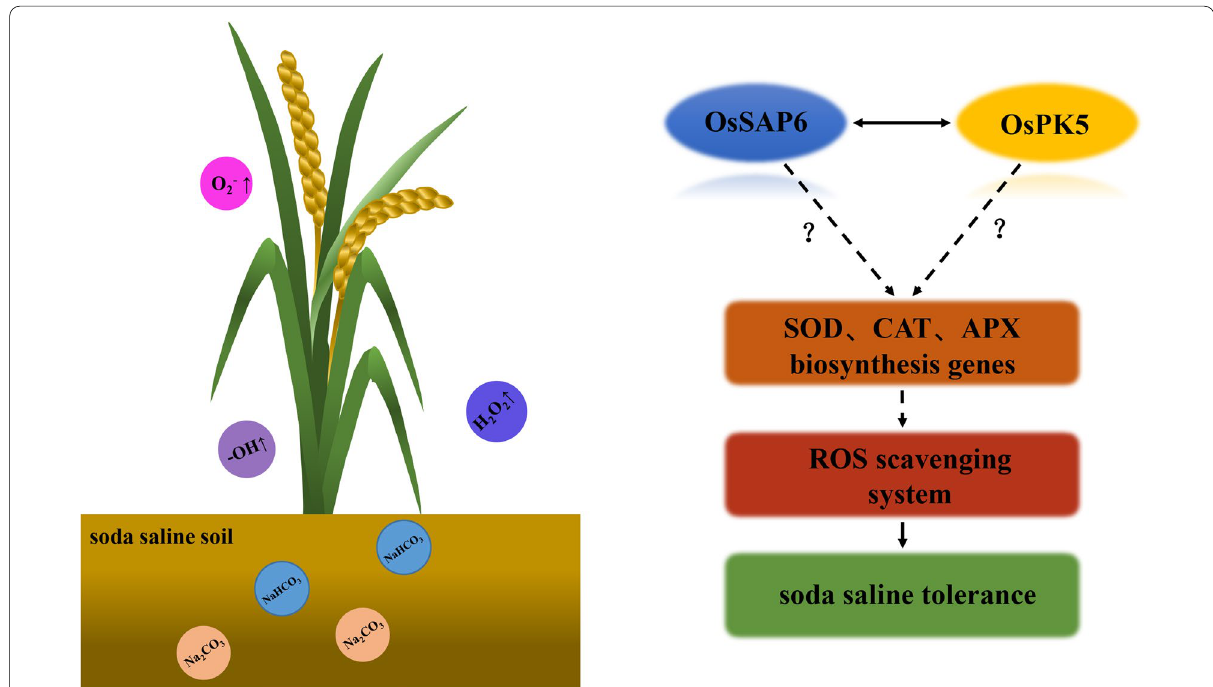
Fig. 8 A brief pathway of OsSAP6 regulation under soda saline–alkaline stress. Overexpression of OsSAP6 upregulates genes involved in ROS scavenging. The expression of these genes leads to a reduction in ROS accumulation, which results in improved tolerance to soda saline–alkaline stress. OsSAP6 also interacts with OsPK5 to positively regulate soda saline–alkaline tolerance through ROS